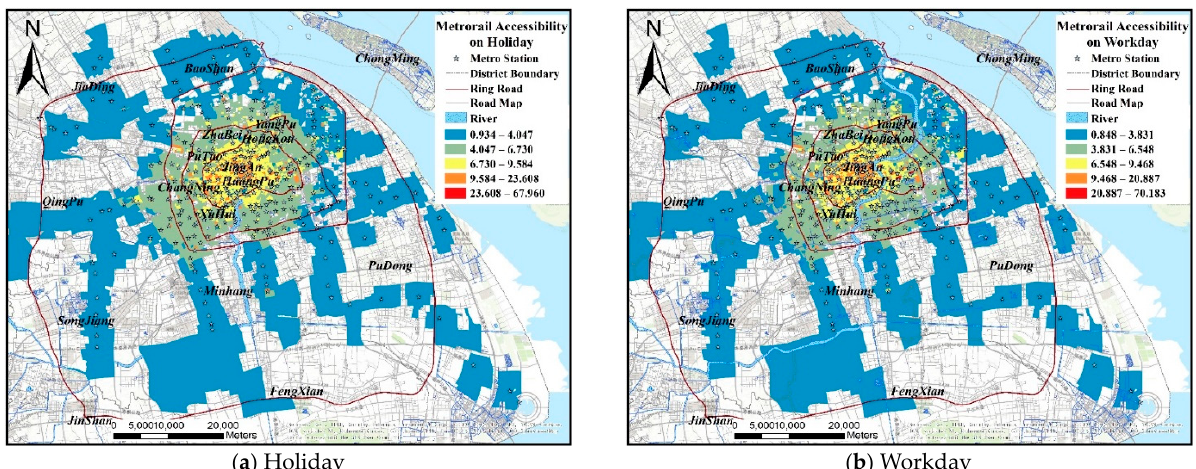
Figure 6. Distribution of metrorail accessibility by the station.